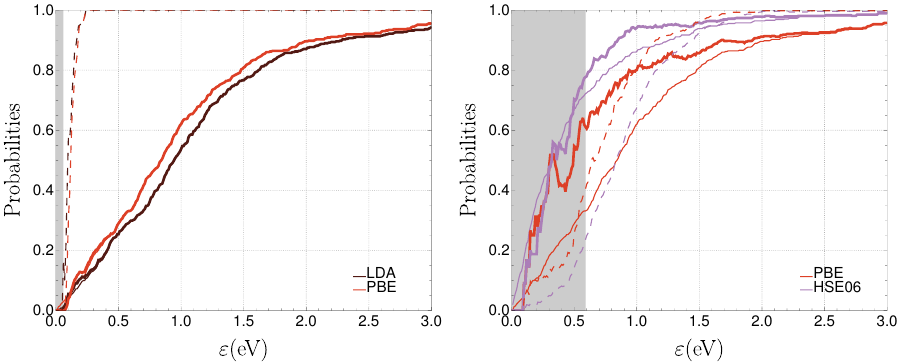
Figure 5. Probabilities for the pairs LDA/PBE ( left panel ) and PBE/HSE06 ( right panel ): P r ( M , (cid:101) ) (thin curves), P r | s ( M , (cid:101) ) (thick curves), and P s | r ( M , (cid:101) ) (dashed curves). The gray rectangle covers the region where the selected sample size is less than